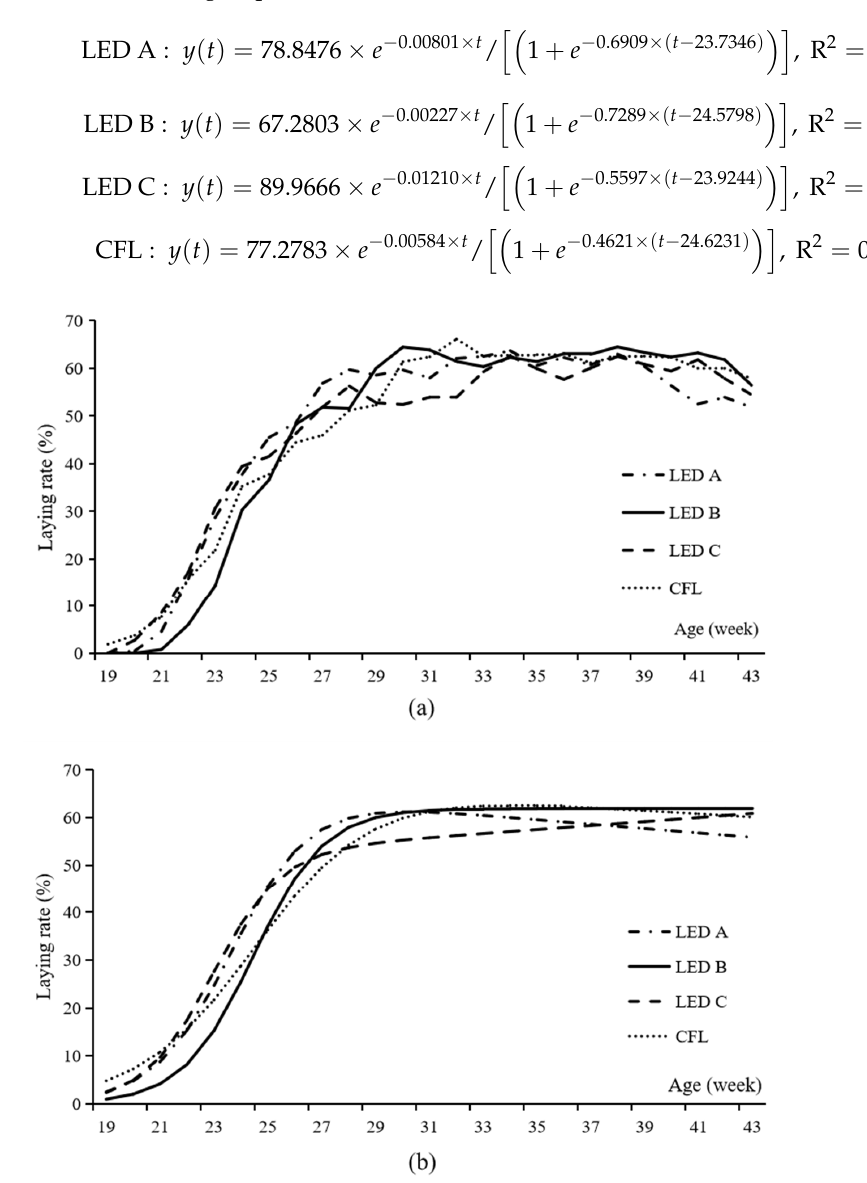
Figure 2. The actual ( a ) and fitted ( b ) laying rate cure of Beijing-You chickens reared under three light emitting diode bulbs and one compact fluorescent lamp. LED, light emitting diode; CFL, compact fluorescent lamp. The out spectrum of blue green, yellow, and red light is 21%, 30%, 24%, and 25% for LED A; 35%, 35%, 18%, and 12% for LED B; 27%, 30%, 22%, and 21% for LED C; and 15%, 28%, 41%, and 16% for CFL,